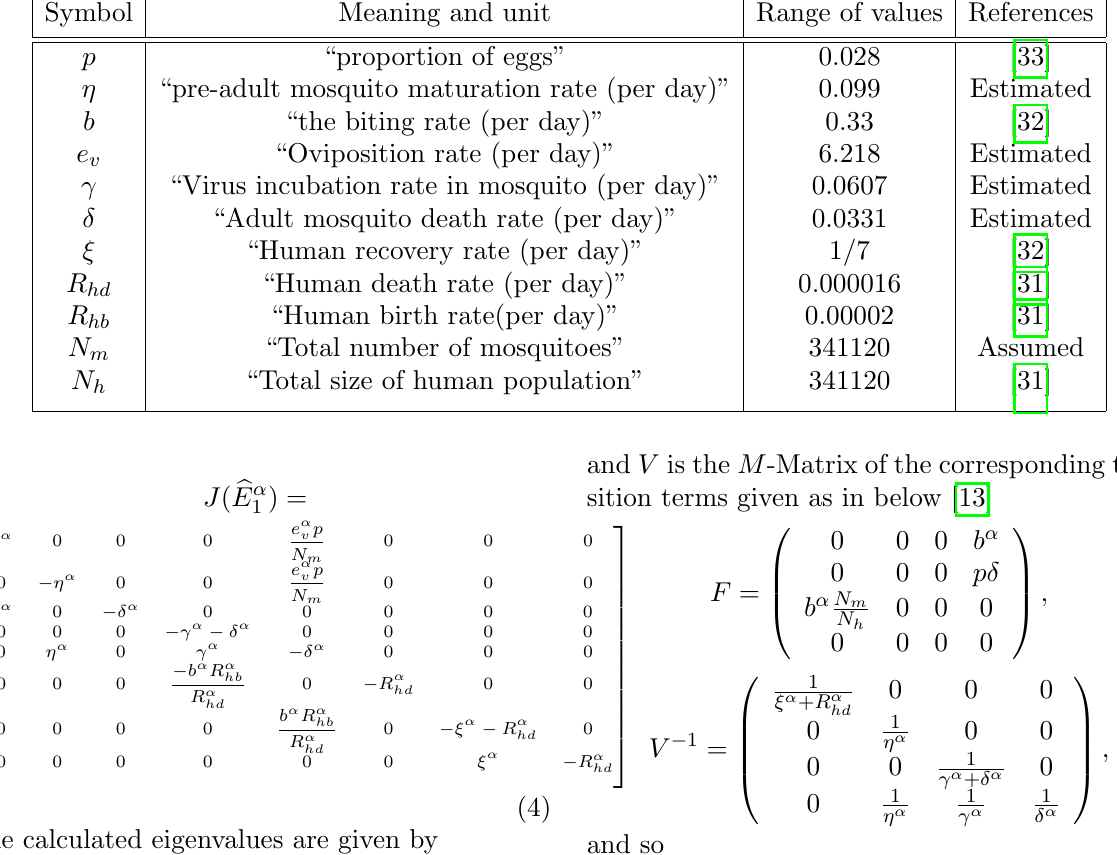
Table 1. Dengue model parameters (at temperature 25 ◦